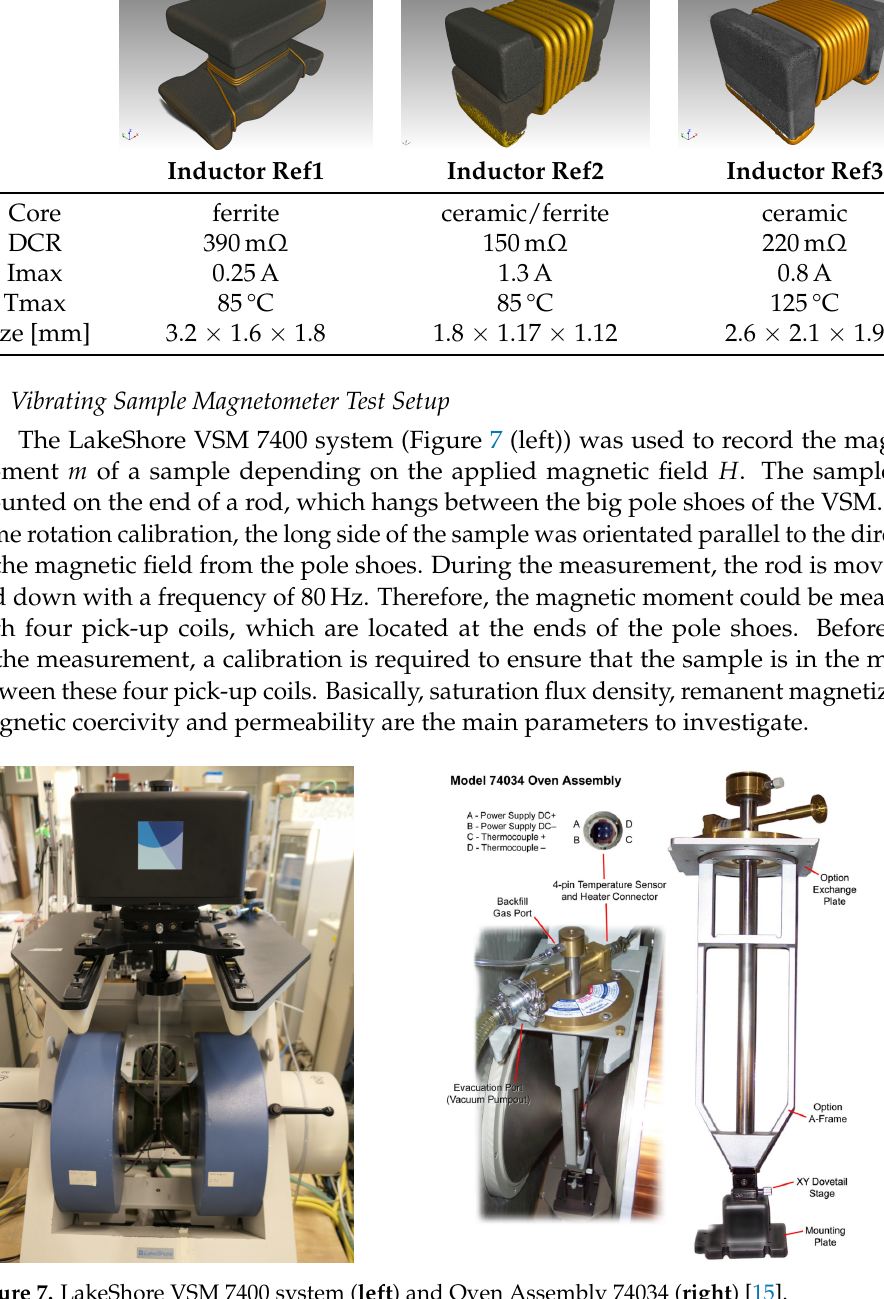
Figure 7. LakeShore VSM 7400 system ( left ) and Oven Assembly 74034 ( right ) [15]. Temperature Stable